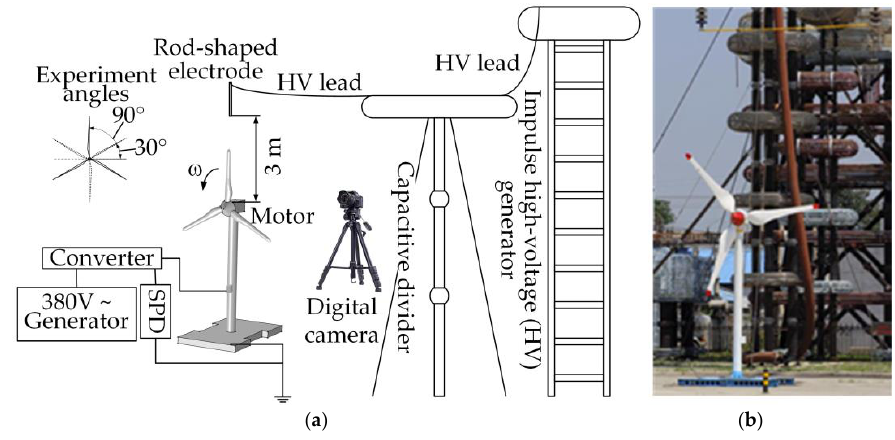
Figure 10. ( a ) Schematic diagram of experimental setup; ( b ) the actual wind turbine scaled model.